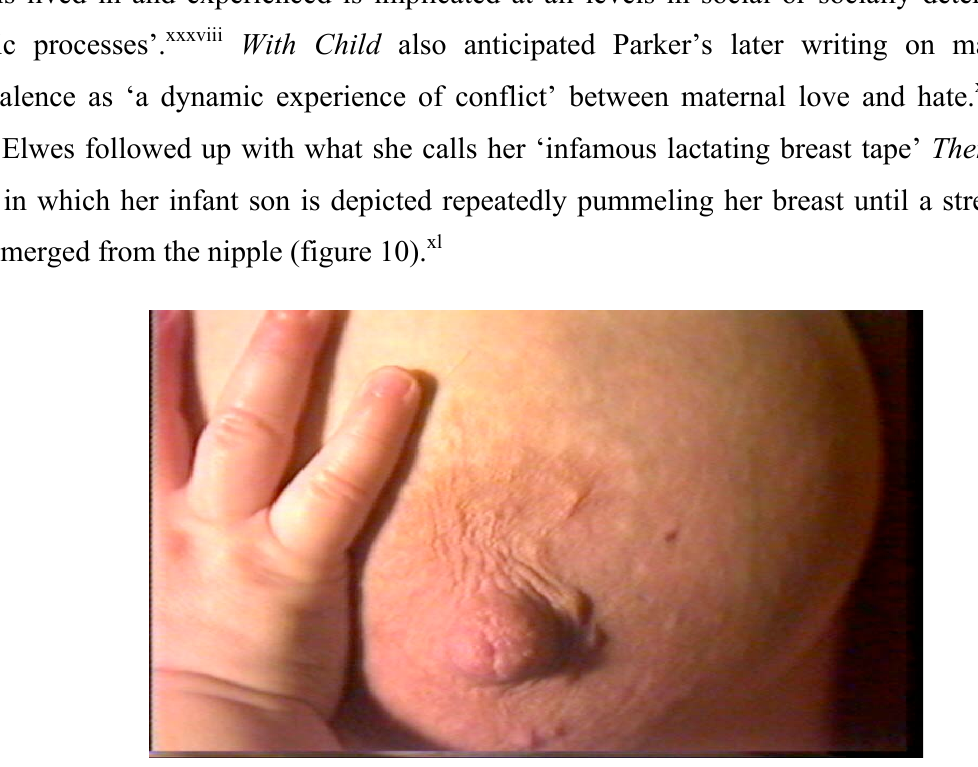
Figure 10: Cate Elwes There is a Myth 1984. Video